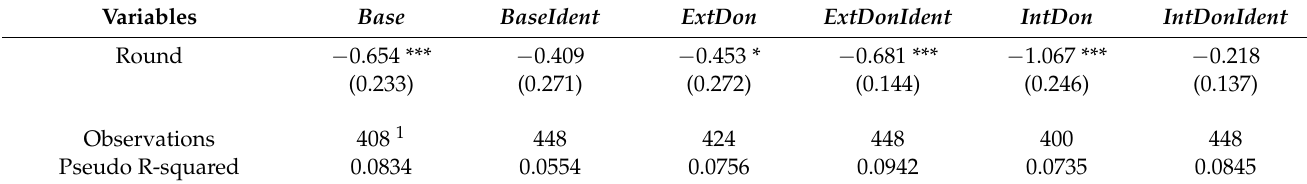
Table 4. Section of Tobit regression on individual contribution by